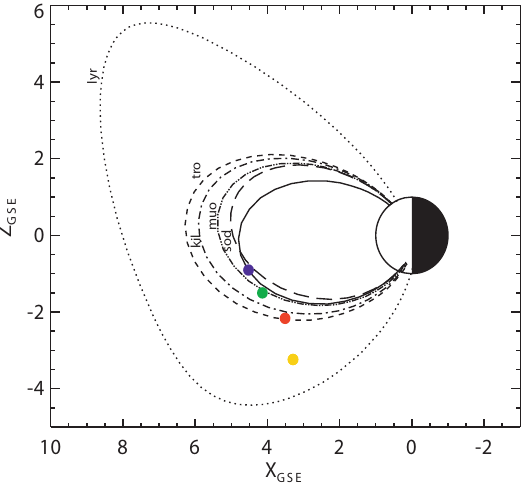
Fig. 3. Satellite positions with respect to geomagnetic field lines projected into the GSE XZ plane corresponding to IMAGE- network stations on 22 August 2002 at 11:15 UT. The field is cal- culated using the Tsyganenko 96 magnetic field model (solar wind pressure 2nPa, B y = B z =0 nT, D st = − 50nT). Solid circles in blue, green, yellow and red represent the positions of spacecraft 1, 2, 3 and 4, respectively. The field line has been traced for spacecraft 1 (solid line), the IMAGE stations (dashed and dot-dashed lines), and the relative positions of the other Cluster spacecraft have been